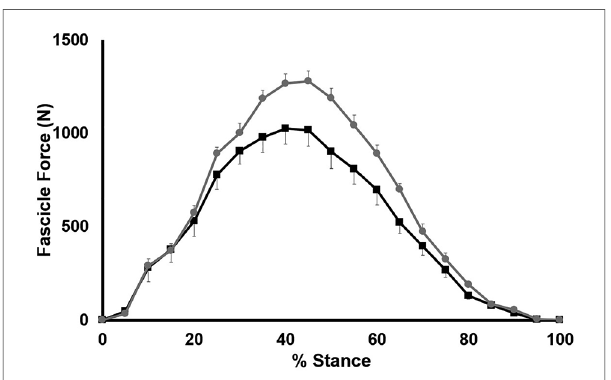
FIGURE 8 Time-normalized AT force over the stance phase of running. Values are presented as mean±SD. Grey circles represent the SHORT AT MA group, while black squares represent the LONG AT MA